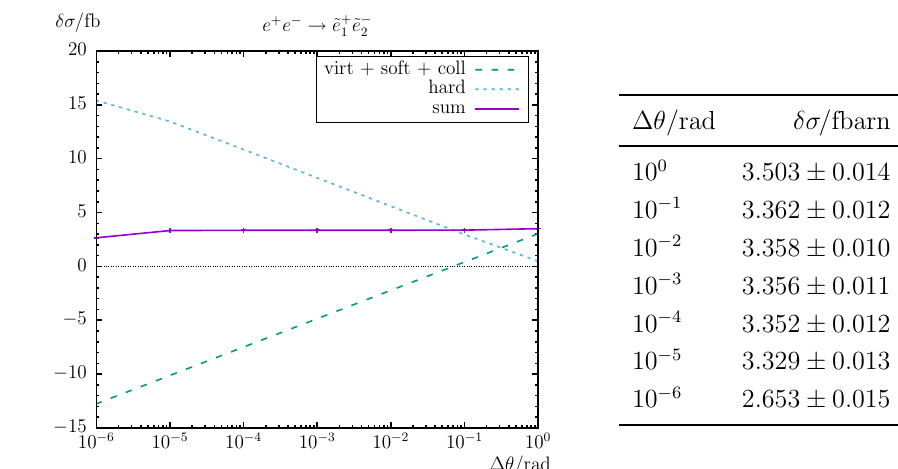
Fig. 3 Phase space slicing method. The different contributions to the one-loop corrections δσ( e + e − → ˜ e +